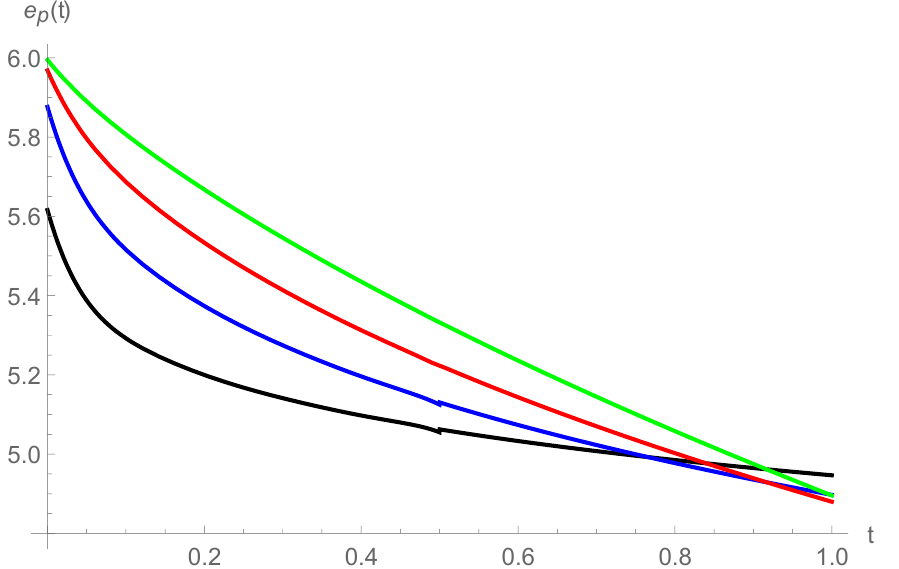
Figure 8. The effect of υ on the distribution of e p ( t ) . Black: υ = 0.2, Blue: υ = 0.4, Red: υ = 0.6, Green: υ =